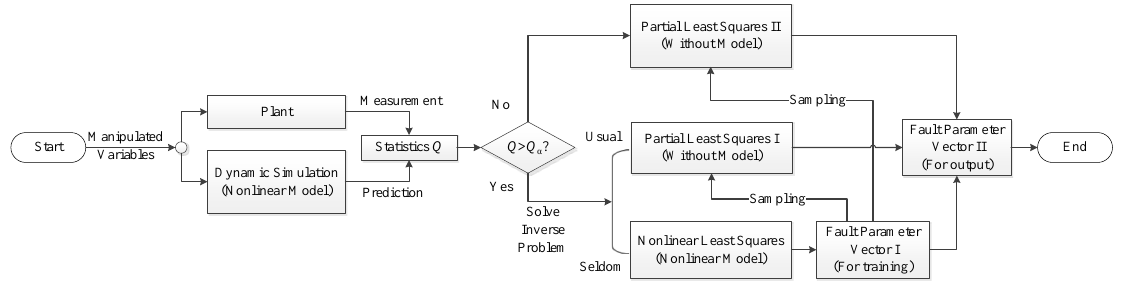
Figure 1. Hybrid inverse problem-solving process for fault diagnosis.